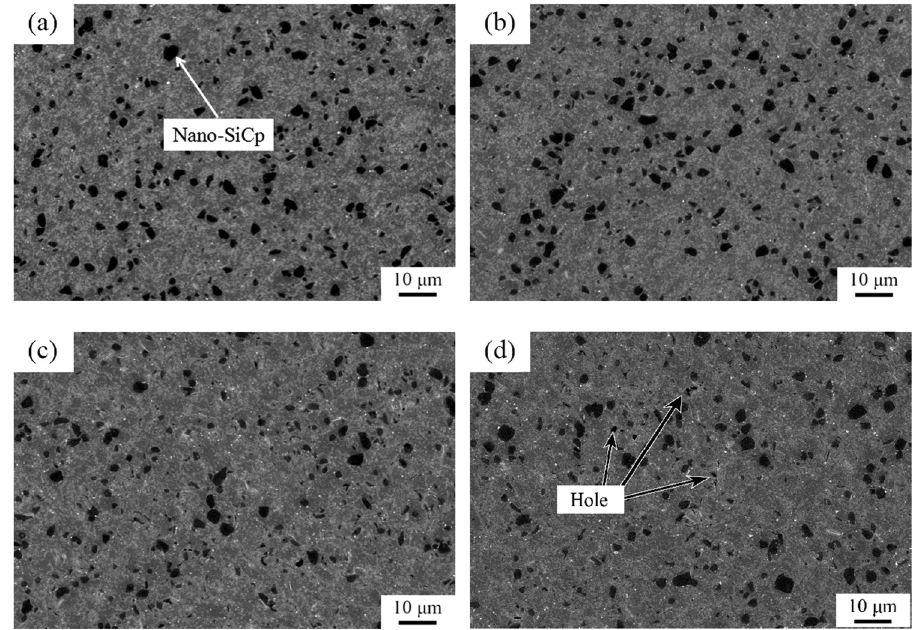
Figure 2: SEM images of composites with di ff erent nano - SiCp volume fraction: ( a ) 1% SiCp, ( b ) 2% SiCp, ( c ) 3% SiCp, and ( d ) 4%